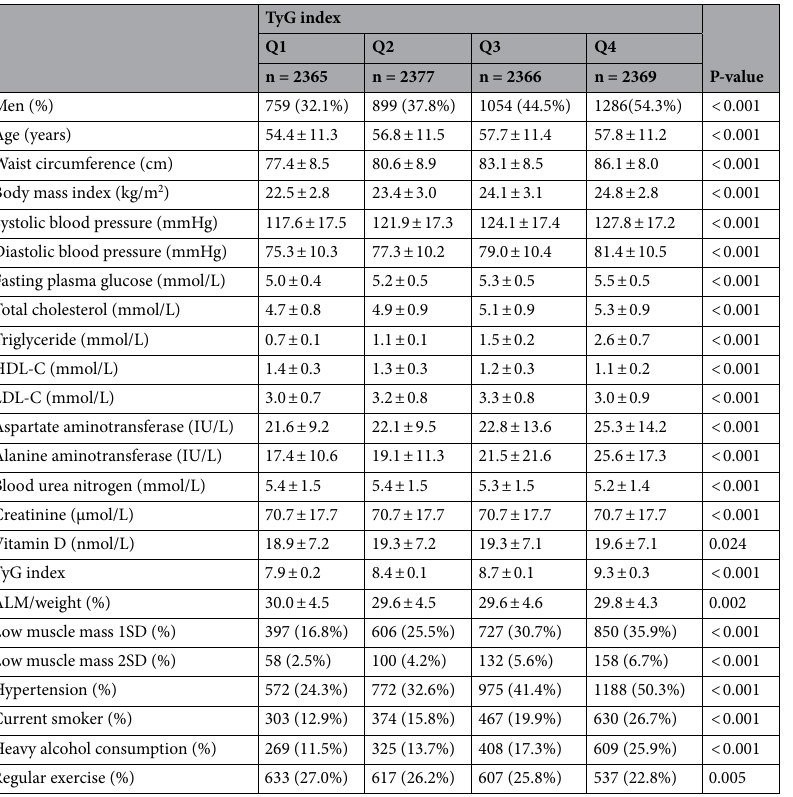
Table 1. Baseline characteristics according to the quartiles of the TyG index. Data are expressed as mean ± SD or n (%). ALT alanine aminotransferase; ALM Appendicular lean mass; HDL-C High-density lipoprotein cholesterol; LDL-C Low-density lipoprotein cholesterol; SD standard deviation; TyG index triglyceride-glucose